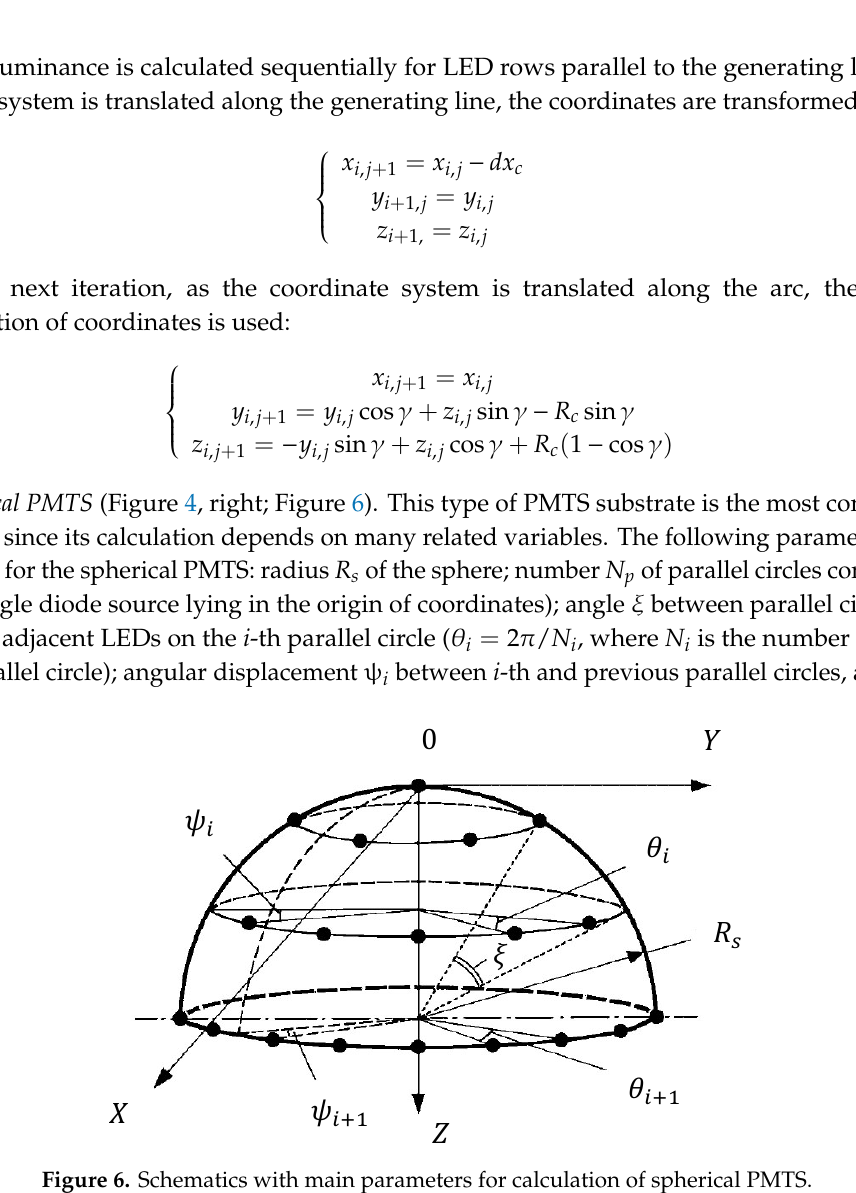
Figure 6. Schematics with main parameters for calculation of spherical PMTS.